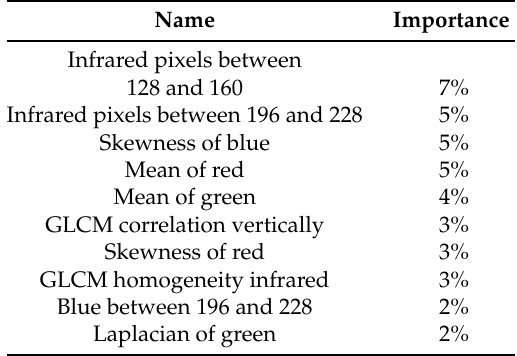
Table 2. Random Forest (RF) feature importance.